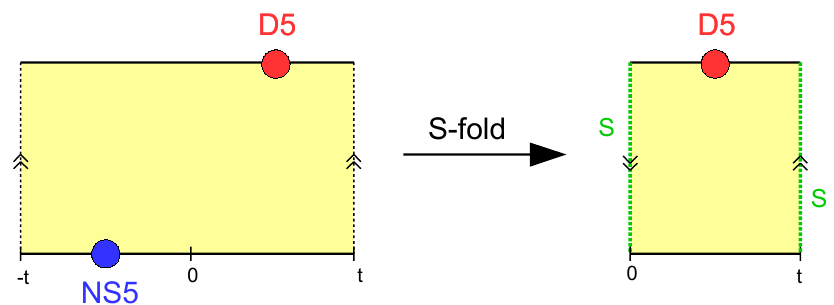
Figure 6 . On the left: the (cid:6) annulus (yellow) with a D5 (red) and an NS5 (blue) singularity, corresponding to the initial ABJM ( k = 1) supergravity solution. On the right: the (cid:6) 0 M(cid:127)obius strip with a single D5 singularity and an S-interface (green dashed line), corresponding to the solution quotiented by S in